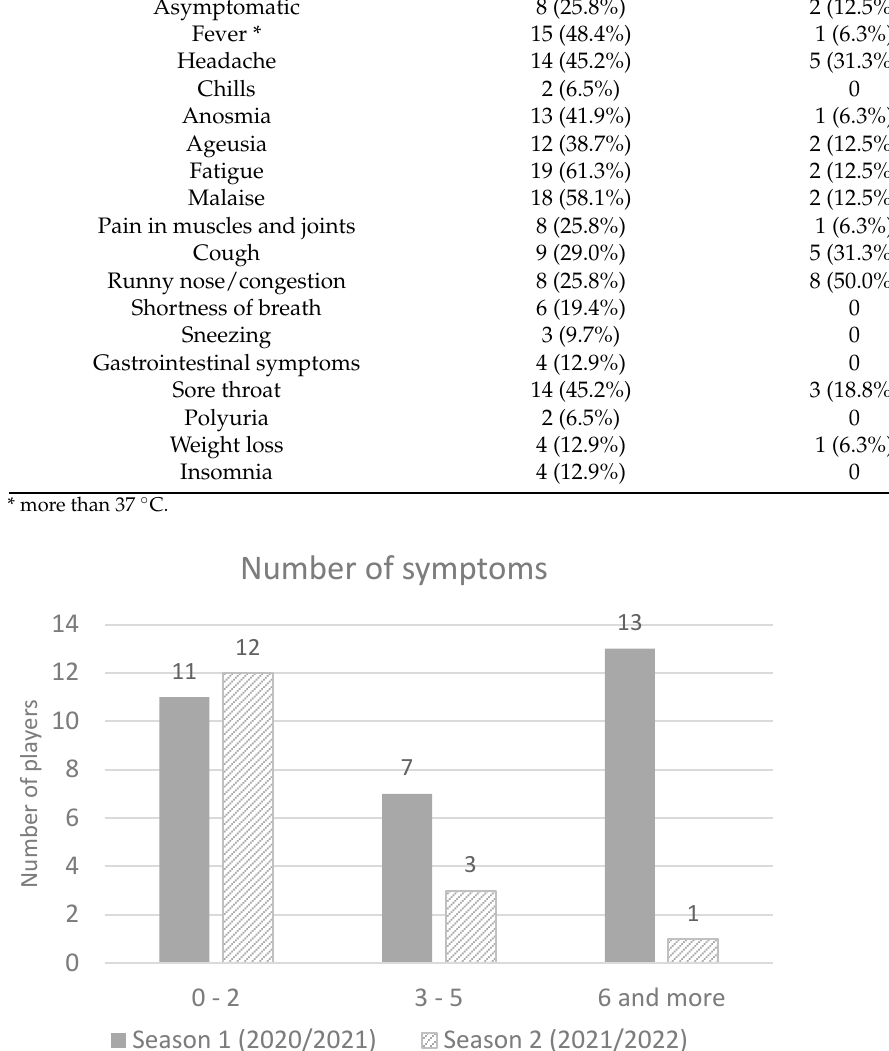
8 of 19 Table 2. COVID-19 symptoms among infected players. Symptoms